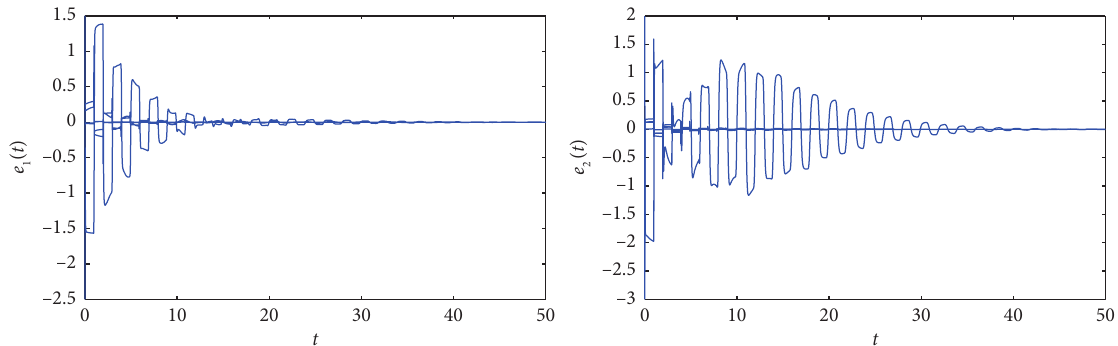
Figure 3: Pinning synchronization errors for fuzzy neural networks: e